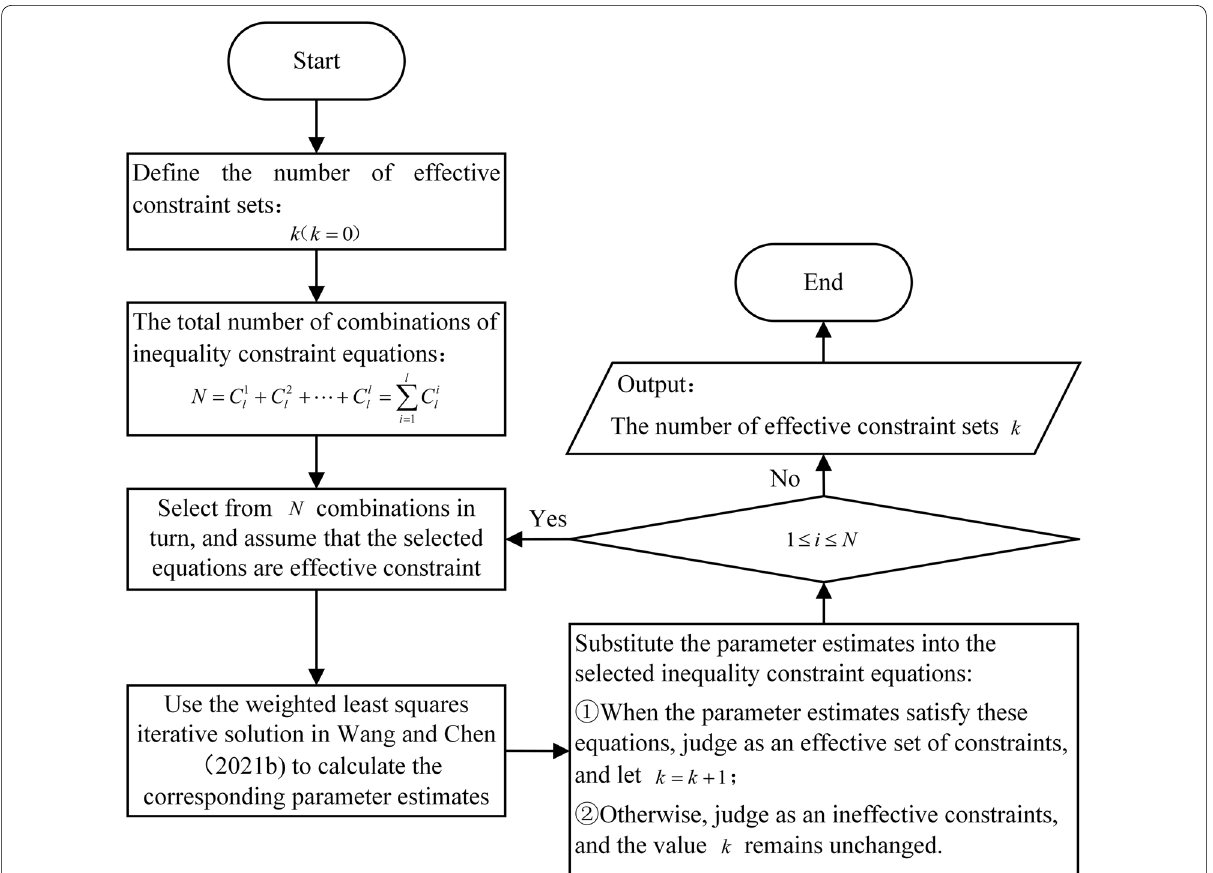
Fig. 1 Flowchart of utilizing the exhaustive search method to solve a MAAMRE model with inequality